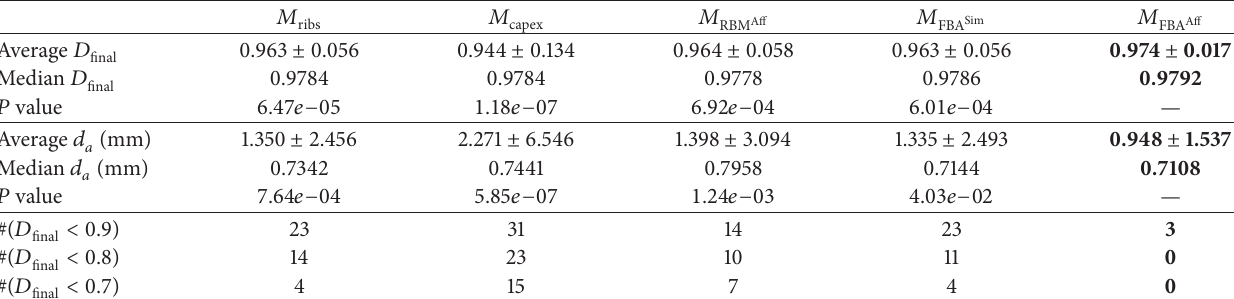
Table 3: Comparison of median and average of final segmentation accuracy as well as the 𝑃 values of a paired Wilcoxon rank test between . For each method, the number of cases # with Dice values below 0.9, 0.8, and 0.7 is each method and 𝑀 FBA Aff